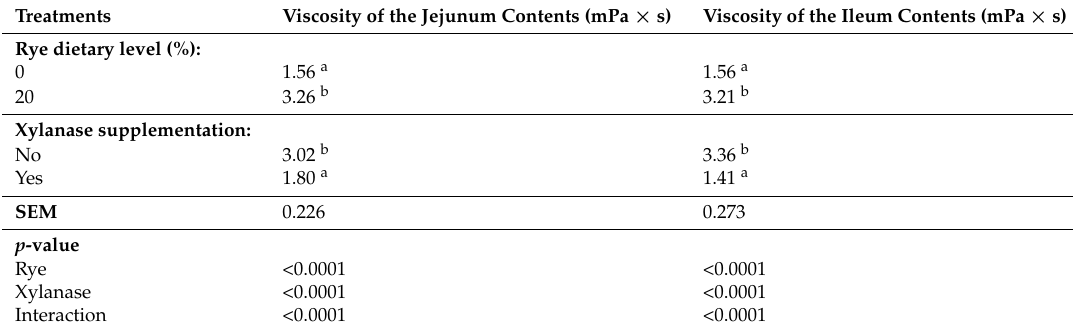
Table 7. Viscosity of the intestinal